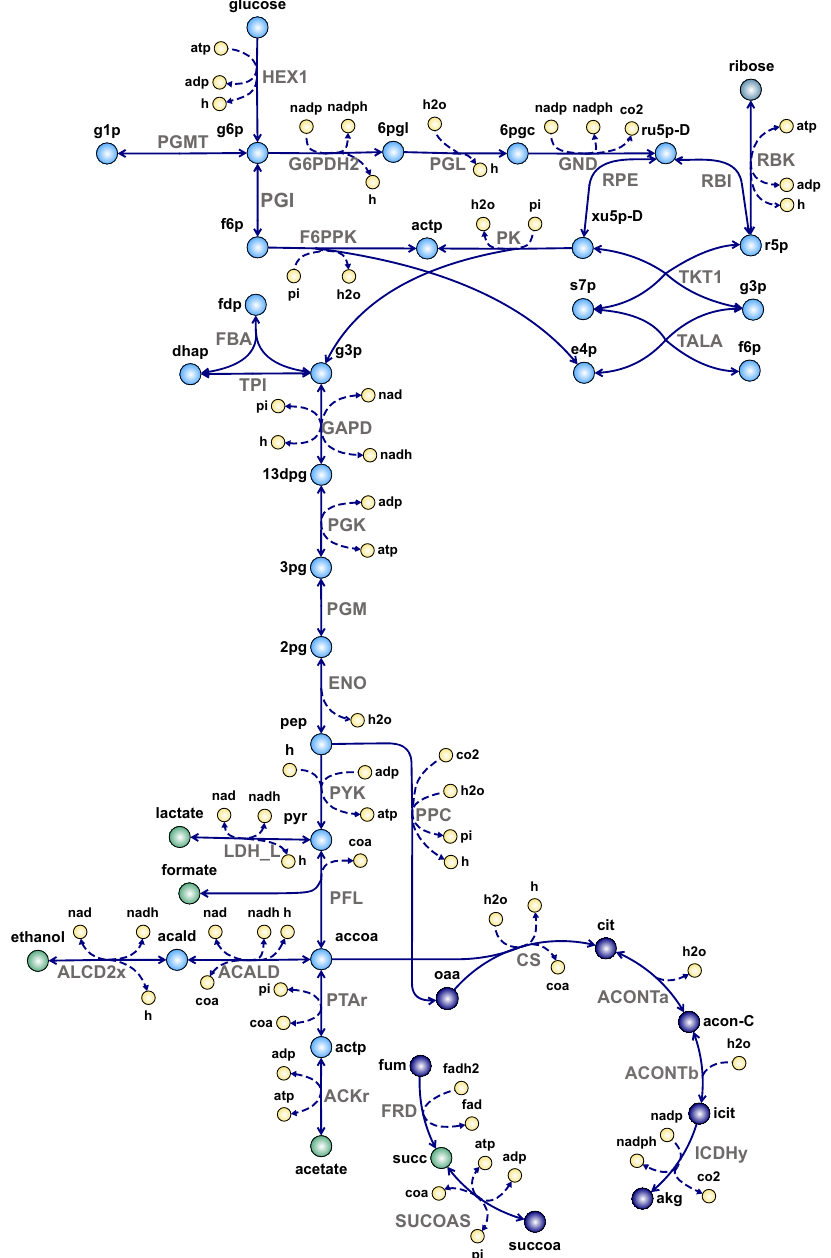
Fig. 1 Central carbon metabolism in bi fi dobacteria, as depicted in i AZ480 and i MS520. Abbreviations of metabolite and reaction names are the same as used in the models (Supplementary Data 3 and